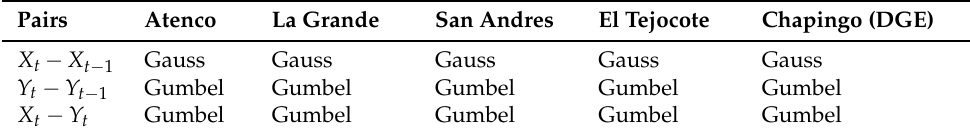
Table 3. Selected copula pairs for all stations.